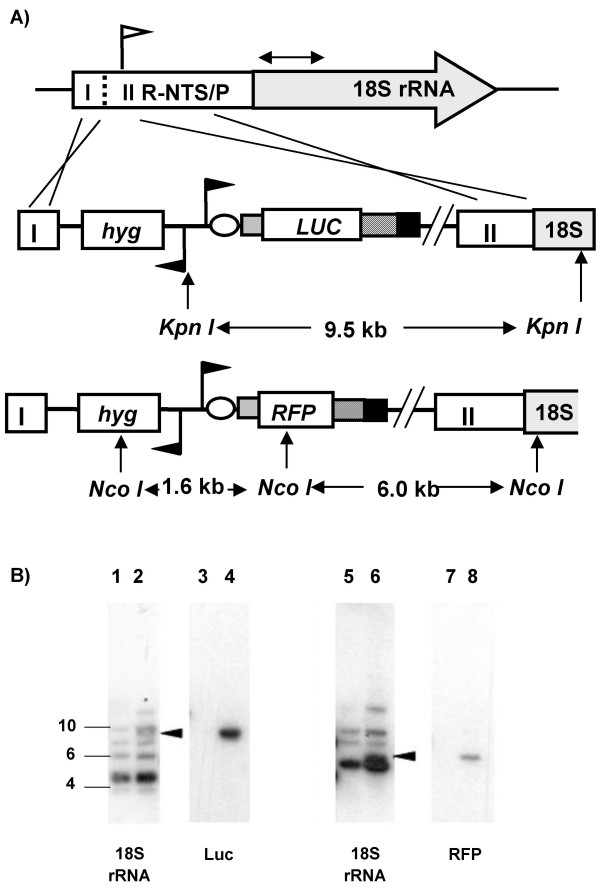
Integration of pTcINDEX-Luc and pTcINDEX-RFP into the ribosomal non- transcribed spacer. (A) Configuration of correctly targeted constructs showing relevant restriction sites. R-NTS/P represents the ribosomal non-transcribed spacer/promoter region with the white flag indicating the promoter [24]. The targeting fragment is designed to integrate upstream of the rRNA transcription start. The dotted line represents the position of the Spe I site introduced into the spacer to facilitate linearization. This site is absent from the genomic DNA. The crossed lines indicate the sites of homologous recombination. The double headed arrow shows the region of the 18S rRNA gene used as a probe when assessing integration. The other symbols are as in Fig. 2. The configurations for integration of pTcINDEX-Luc and pTcINDEX-RFP are shown. The expected fragment size following a targeted integration is illustrated below each map. (B) Southern analysis of the pTcINDEX-Luc and pTcINDEX-RFP transformants Arrowheads indicate fragments specific to the transformants following hybridisation with the 18S rRNA probe. These bands also hybridise specifically to the full-length luciferase or RFP probes. Lanes 1,3,5,7 contain DNA from CL-Brener [pLEW13], lanes 2 and 4 from CL-Brener:pTcINDEX-Luc [pLEW13]. Lanes 6 and 8 contain DNA from CL-Brener:pTcINDEX-RFP [pLEW13]. DNA in lanes 1–4 was digested with Kpn I and in lanes 5–8 with Nco I. The probes used are indicated below each autoradiograph. A second smaller band (1.6 kb) which hybridises to the 5' end of the RFP probe (lane 8) migrated off the bottom of this gel. Molecular sizes are shown in kb.